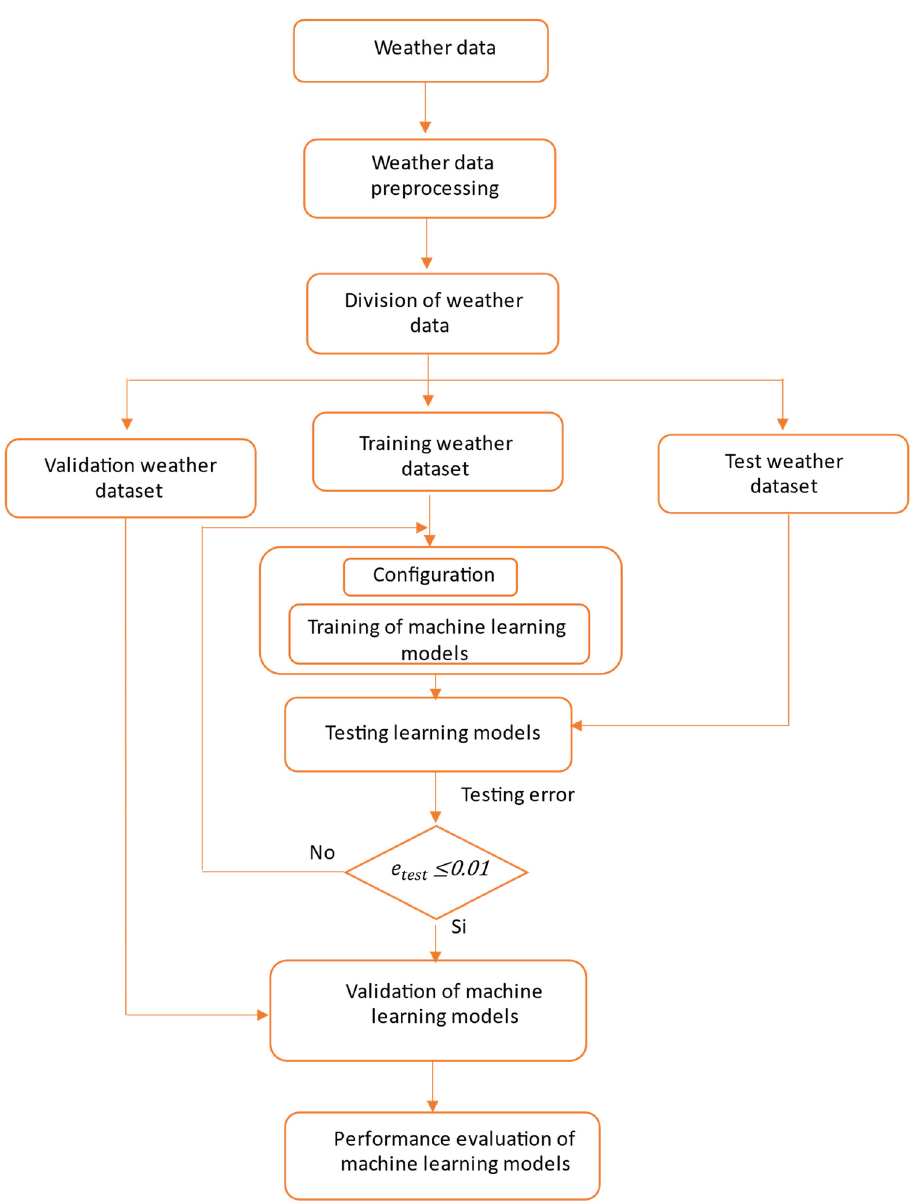
Figure 1. Flowchart of the methodology used to obtain forecasting models for meteorological variables.